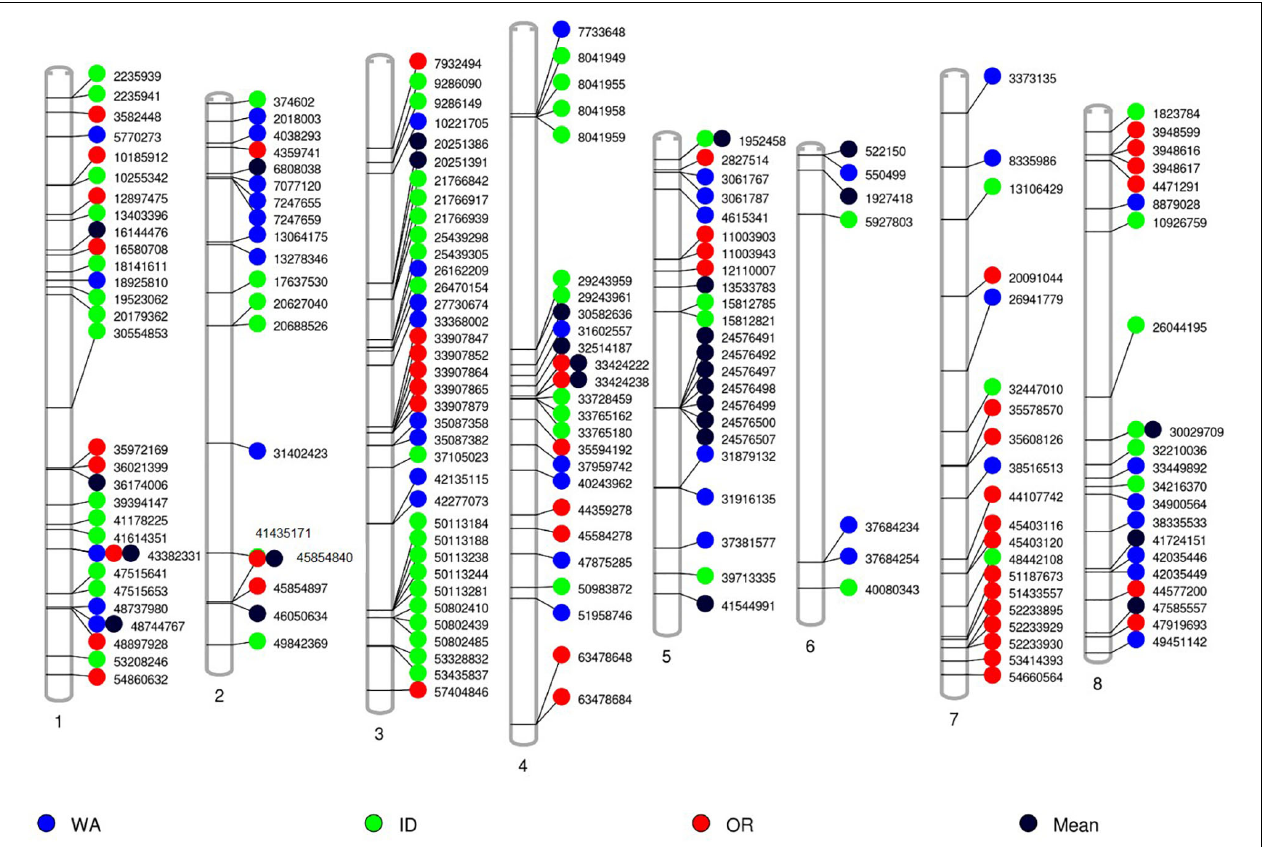
FIGURE 5 | Identification of significant markers associated with alfalfa quality using phenotypic data by location. Markers identified in Washington (WA), Idaho (ID), and Oregon (OR) were displayed in blue, green, and red, respectively. Black spots indicate significant markers based on adjusted means of all quality data collected from three locations for 2